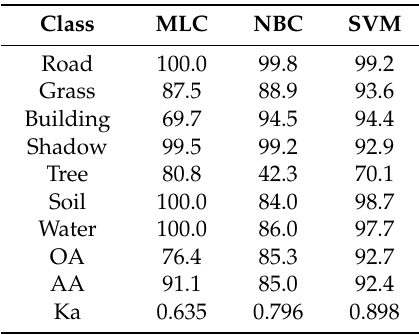
Table 5. Class-specific accuracies (%) for various classifiers and UAV